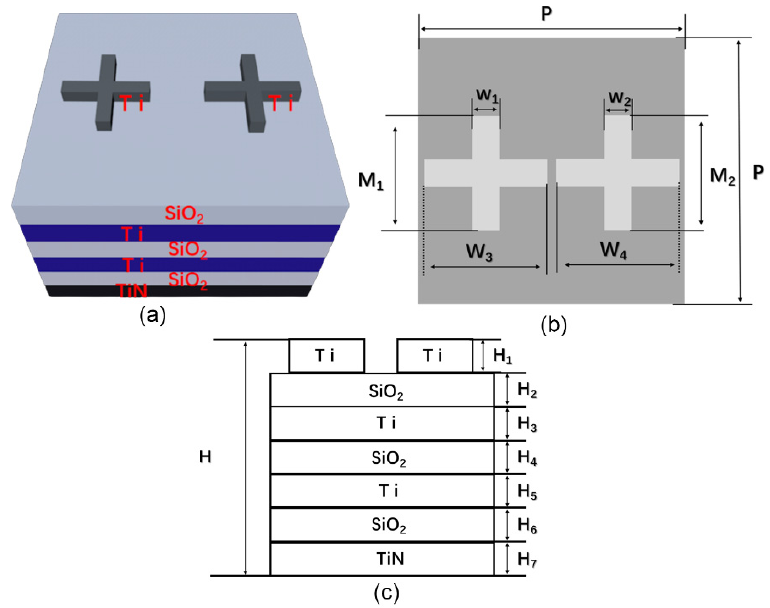
Figure 1. ( a ) Schematic diagram of the ultra-broadband absorber structure ( b ) Top view of the